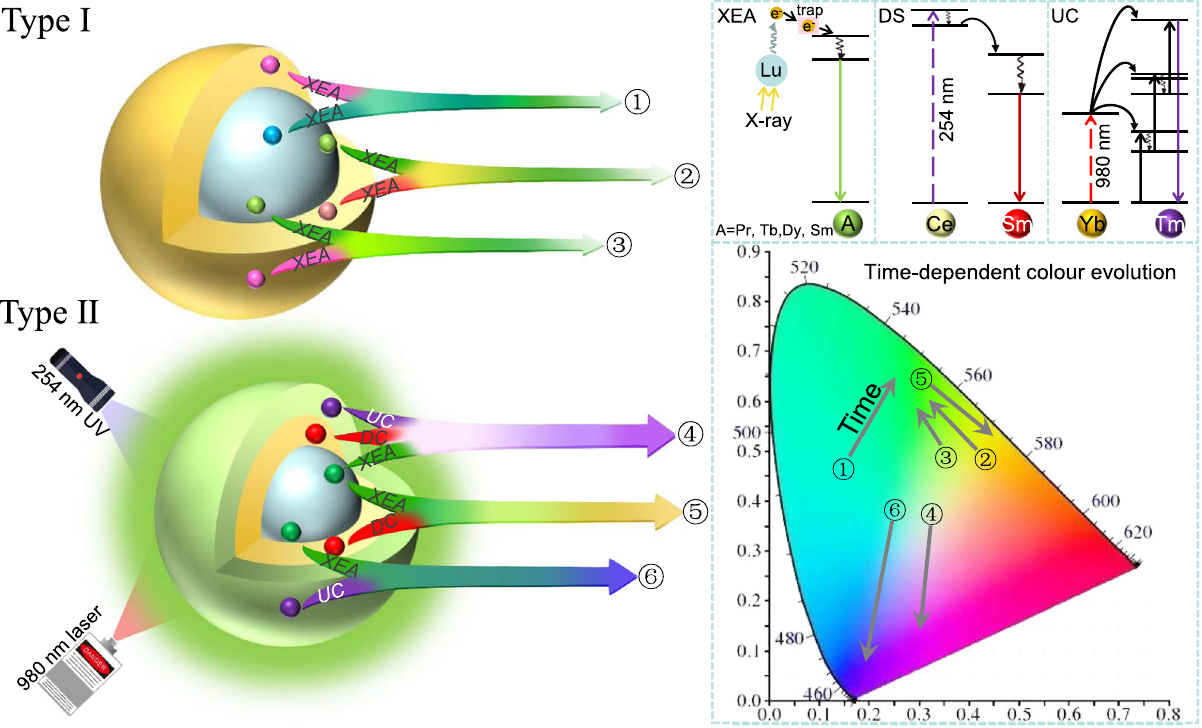
Fig.1|Schematicillustrationoftheproposedtwokindsofuniversalplatforms for the realization of time-dependent multicolour evolutions. In type I, the activatorsinthecoreand shellcould bePr 3+ ,Tb 3+ ,Dy 3+ ,orSm 3+ ions.IntypeII,Tb 3+